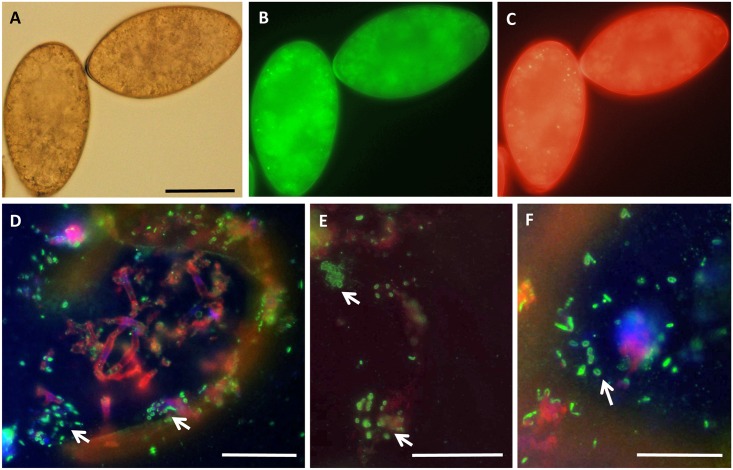
Immunofluorescence detection of Neorickettsia in eggs of F. hepatica from Oregon using polyclonal anti-serum raised against a recombinant surface protein of Neorickettsia of P. elegans (PeNsp-3, green labeling, D-F).(A) Unstained eggs recovered from the liver by regular light microcopy. (B) and (C) Unstained eggs recovered from the liver by immunofluorescence microscopy using different filters demonstrating auto-fluorescence. (D-F) Cross-sections of eggs showing various amounts of Neorickettsia (arrows). Bar corresponds to 50 μm.